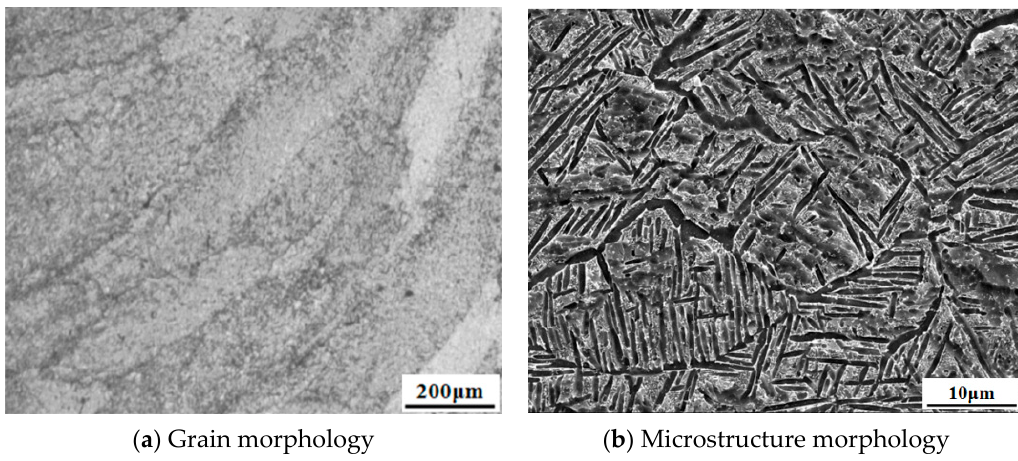
Figure 9. Microstructure in the thermo-mechanically affected zone (TMAZ) of the joint after heat treatment.